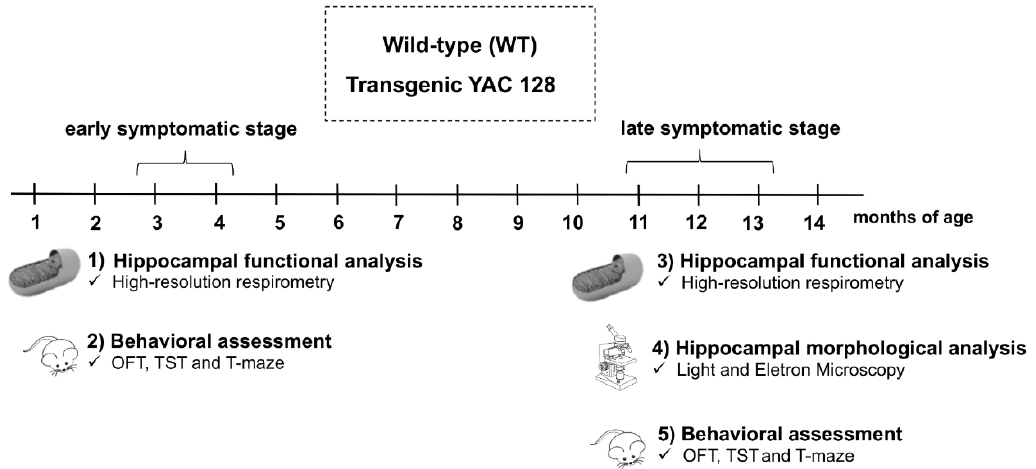
Figure 1. Experimental protocol. Adult male and female WT and YAC128 mice were evaluated at two distinct stages: early (3 to 4 months of age) and late (11–13 months of age) symptomatic. Animals were divided into five cohorts. For behavioral analyses, animals were submitted to the Open-Field Test (OFT), the Tail Suspension Test (TST), and T-maze Swimming Test. Hippocampal mitochondrial function using high-resolution respirometry was performed at both the early and late symptomatic stages, while hippocampal morphological and ultrastructural analyses were only performed at the late symptomatic stage.